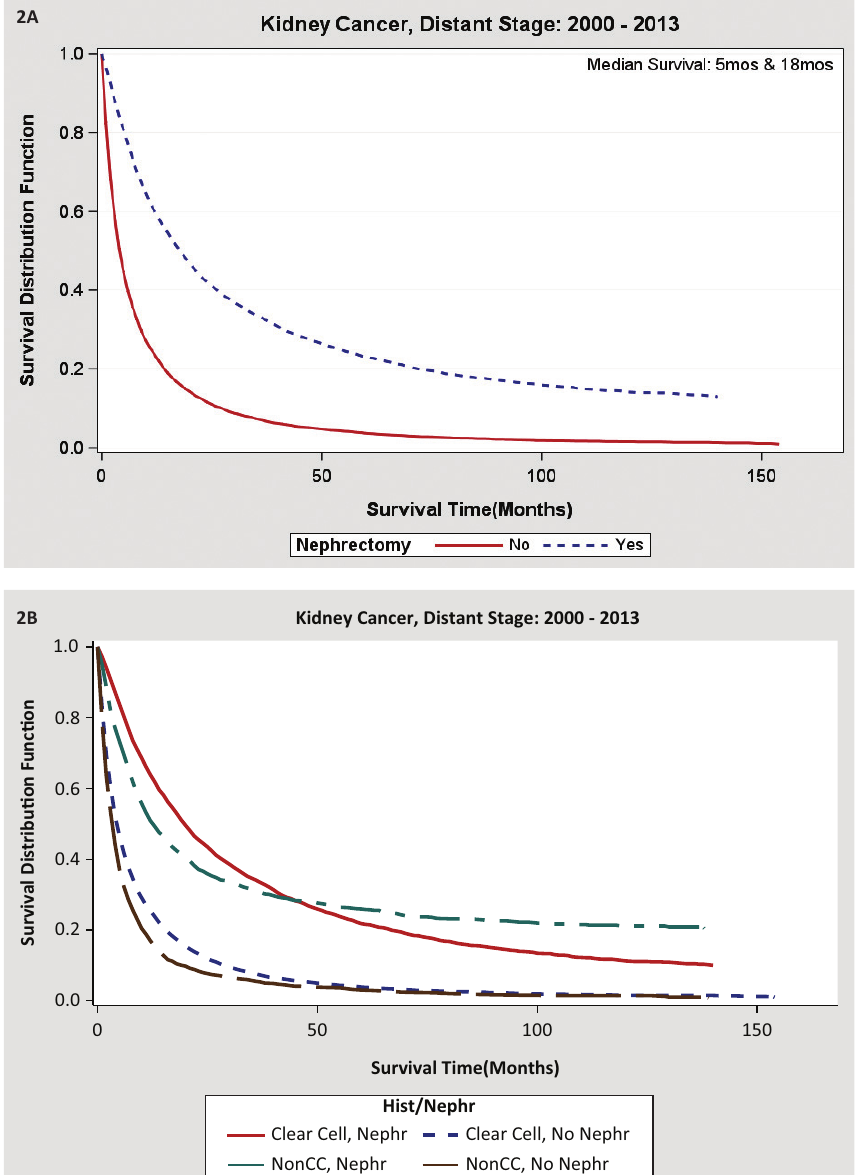
Figure 2: (A) Overall survival data for nephrectomy or non-nephrectomy patients with advanced kidney cancer in SEER data- base. (B) Overall survival outcomes in metastatic RCC by clear and non-clear histology with or without